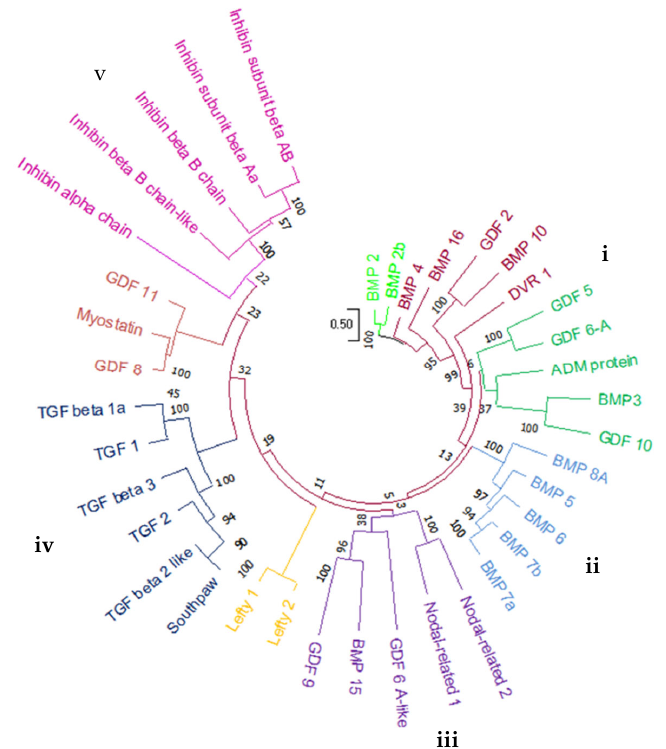
Figure 4. Phylogenetic relationship of 38 BMP members identified in zebrafish genome. Phylogenetic tree was produced using a maximum likelihood (ML) method with 1000 bootstrap replicates in MEGA-X software. I–V represent five major clades.